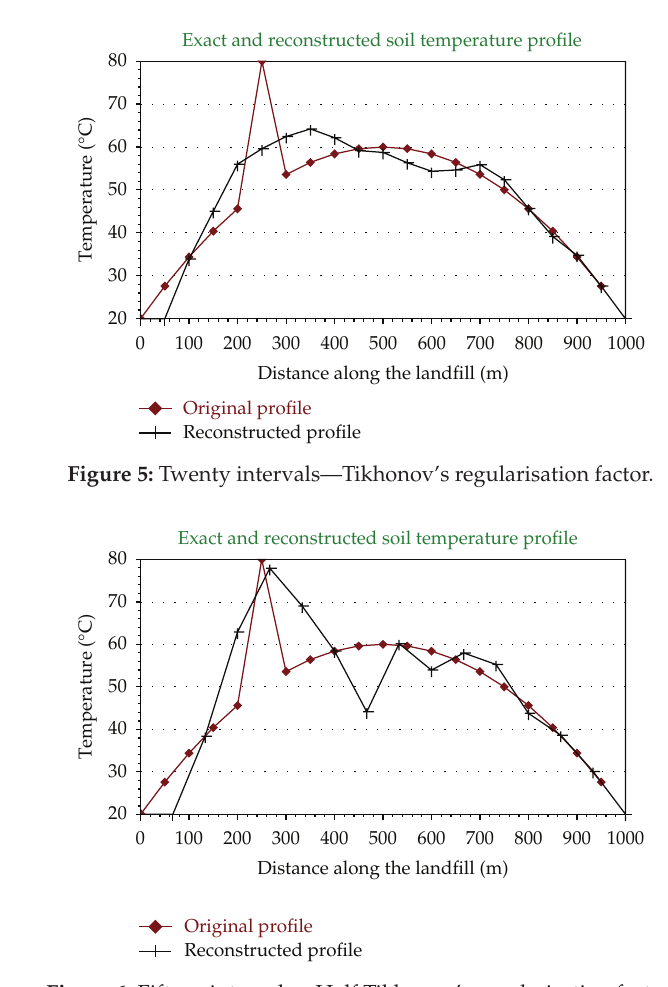
Figure 6: Fifteen intervals—Half Tikhonov’s regularisation factor.